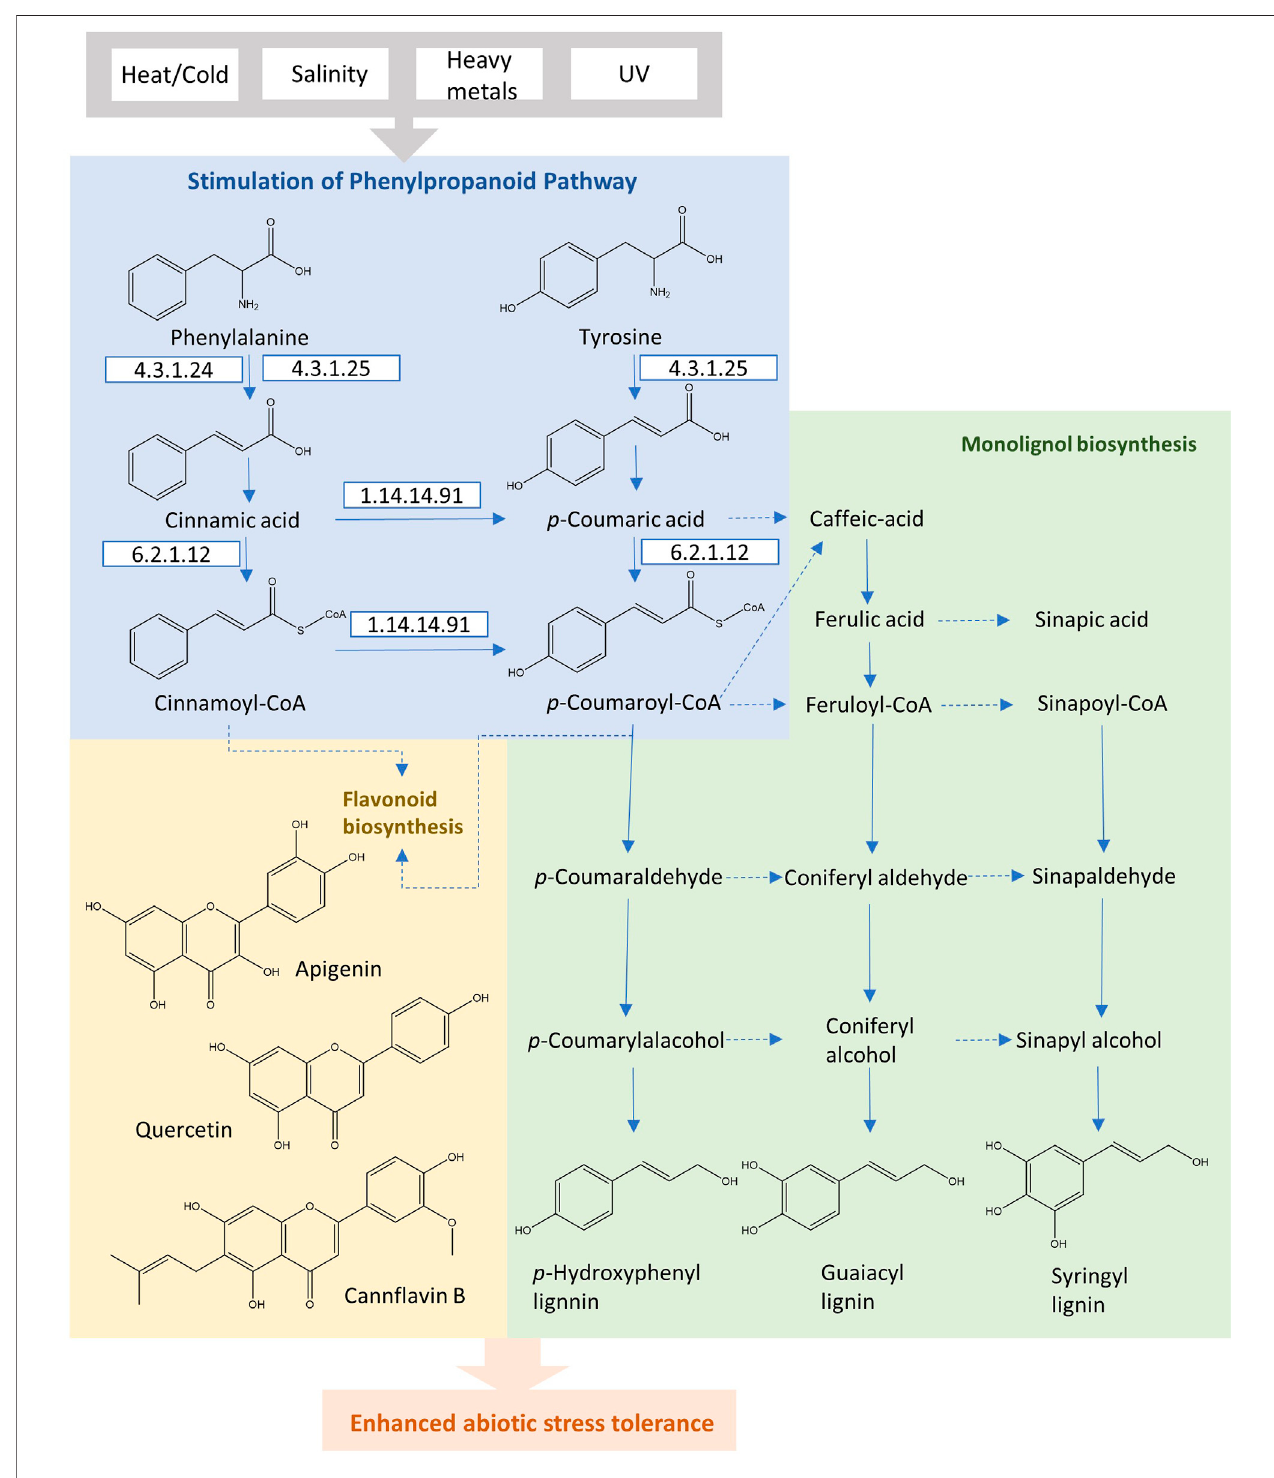
FIGURE 3 | The phenylpropanoid pathway in plants for the production of fl avonoids and monolignols under abiotic stress conditions.